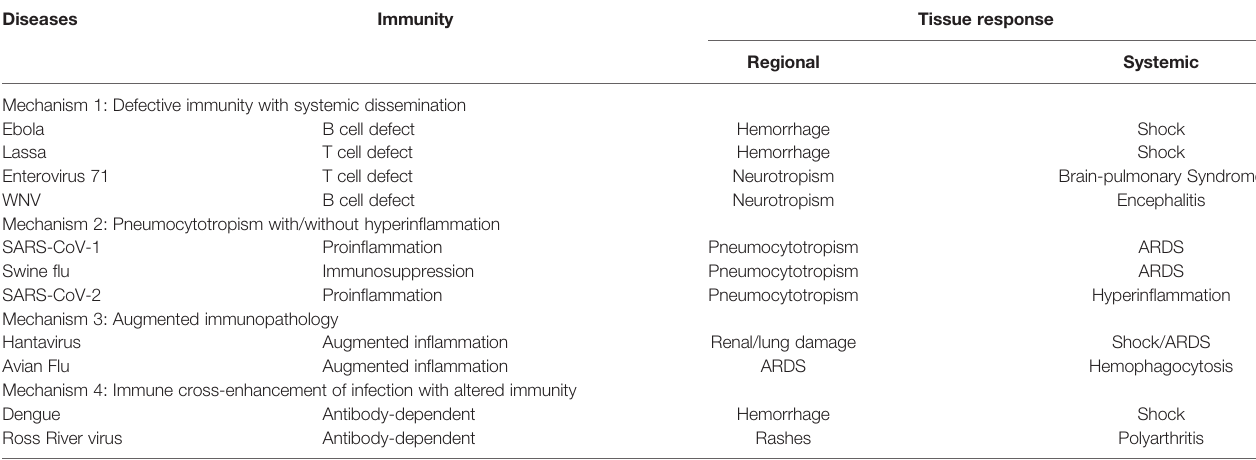
TABLE 2 | Mechanisms of different emerging infections.